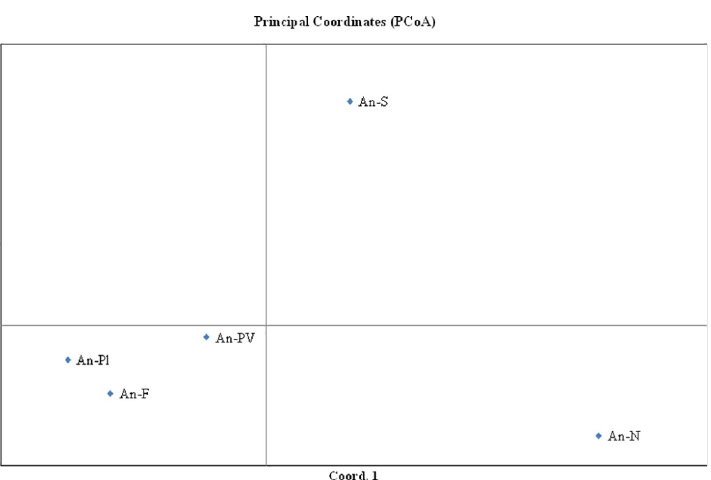
Fig 4. Distribution of variates in a two-dimensional Principal Coordinates Analysis (PCoA) based on corrected F ST values for Asperula naufraga subpopulations.